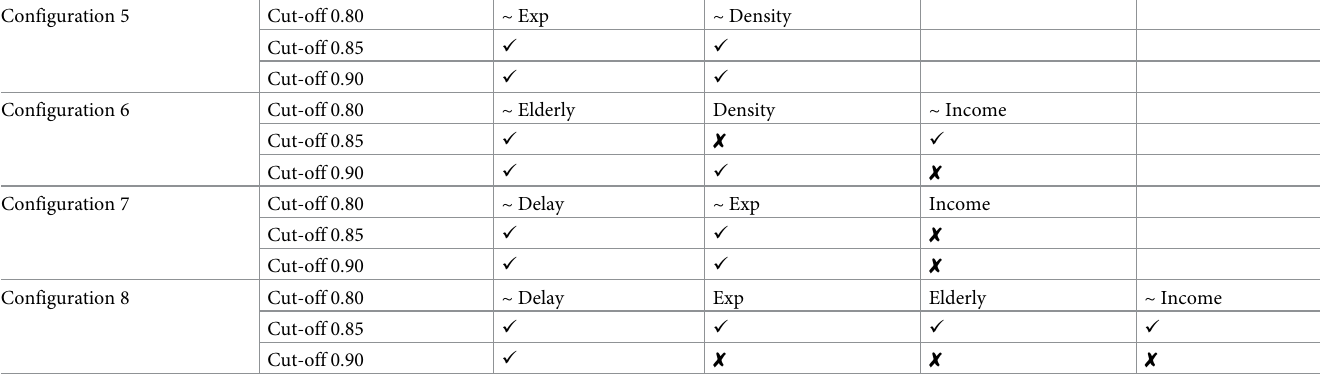
Table 7. Comparison of configurations for low YLL rate at different